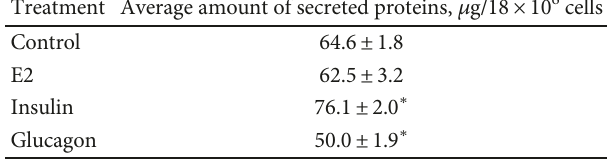
Table 1: E ff ect of hormones on the amount of protein secreted by neutrophils in adhesion to fi